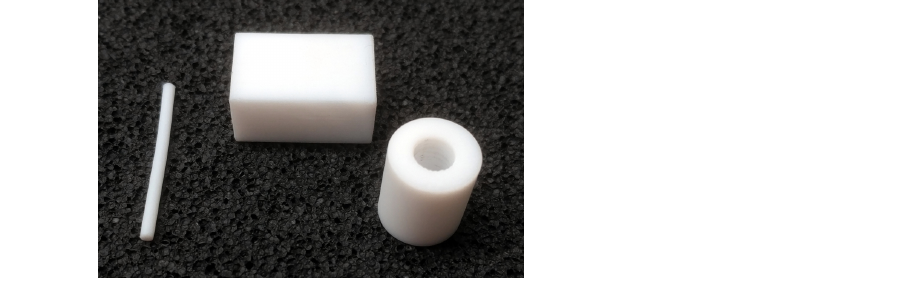
Figure 1. PTFE Material samples for the different measurement techniques: 2-mm diameter rod for the resonator, brick for the waveguide, and annular cylinder for the coaxial transmission line.